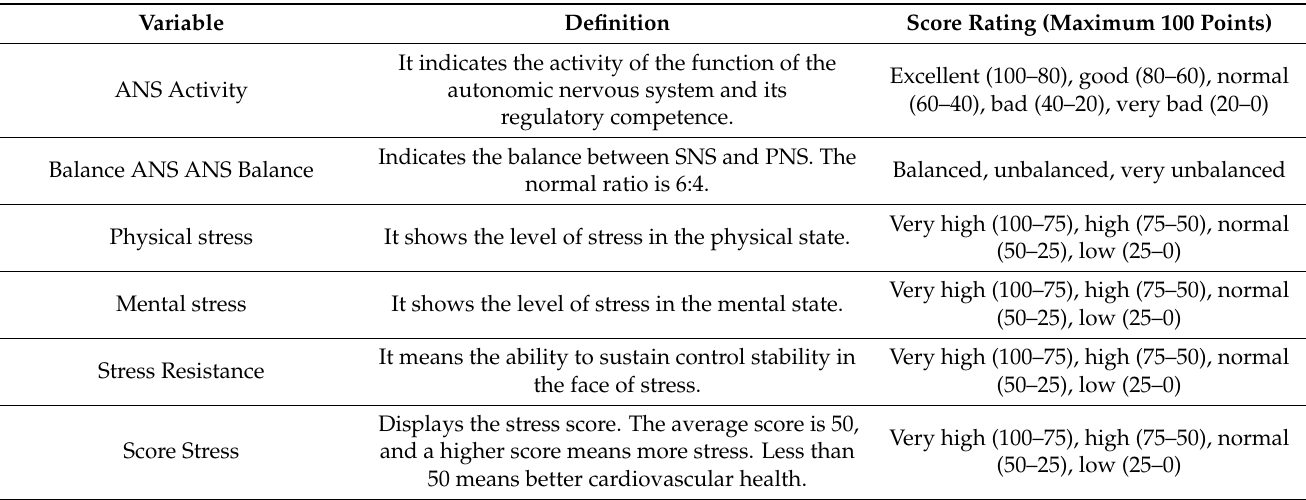
Table 1. Variables of autonomic nervous activity and